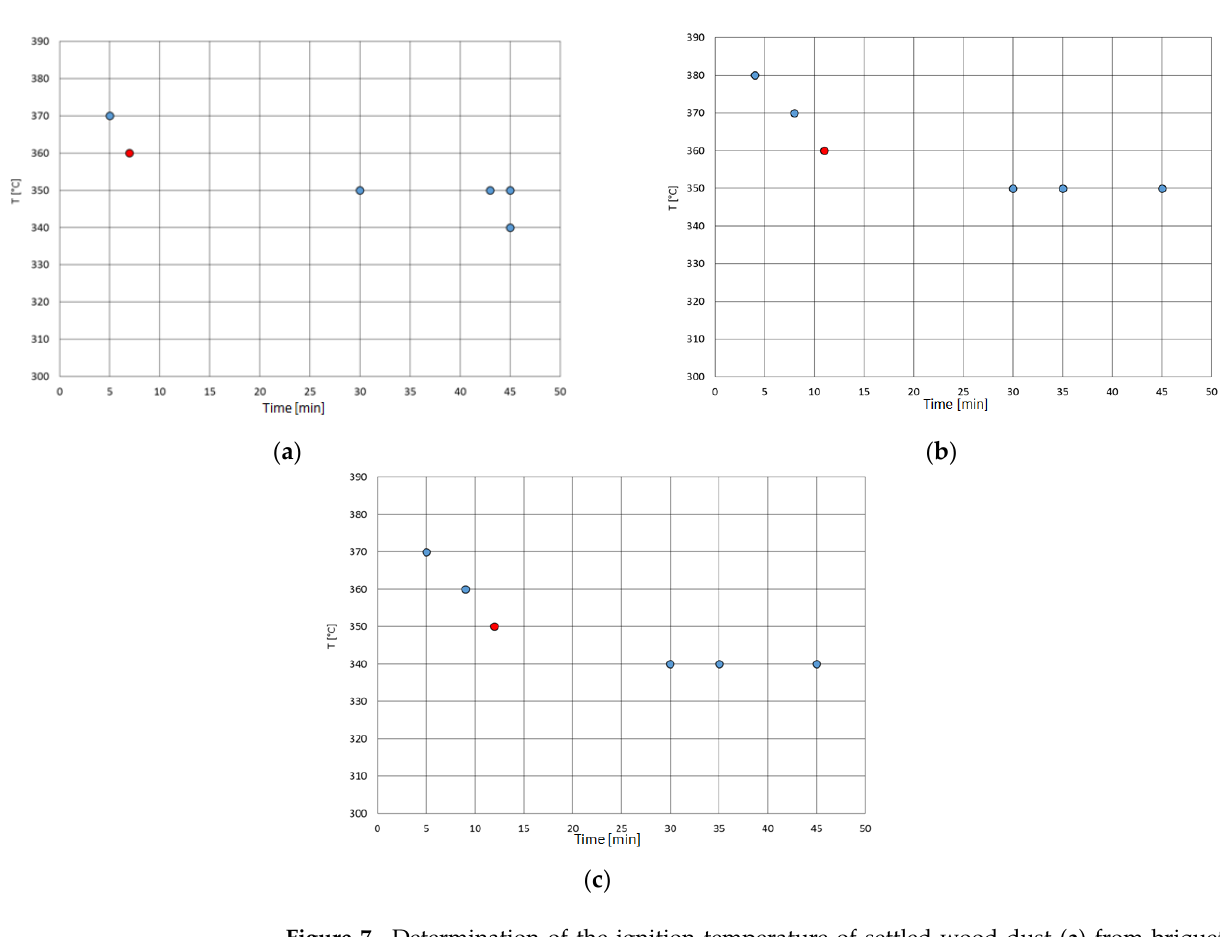
9 of 13 Figure 6. Smoldering nests around the perimeter of the sample WD_ExtrD caused by the ignition source, i.e., a hot surface. Spruce dust samples from briquetting (Figure 7a), suction (Figure 7b) and grinding (Figure 7c) were ignited. The obtained data were different (Table 6).Schemes followed the same formatting. Table 6. Presentation of material parameters of spruce dust samples.